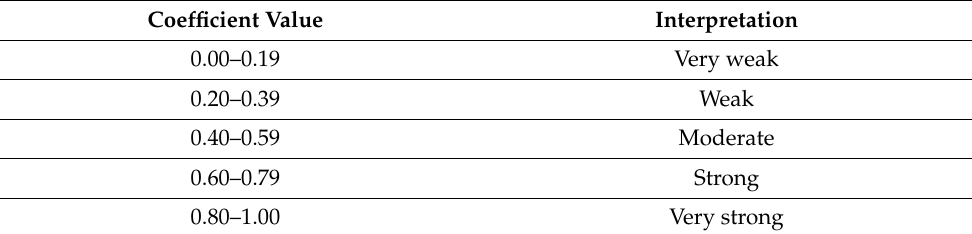
Table 2. Interpretation of correlation coefficient according to Evans [30].